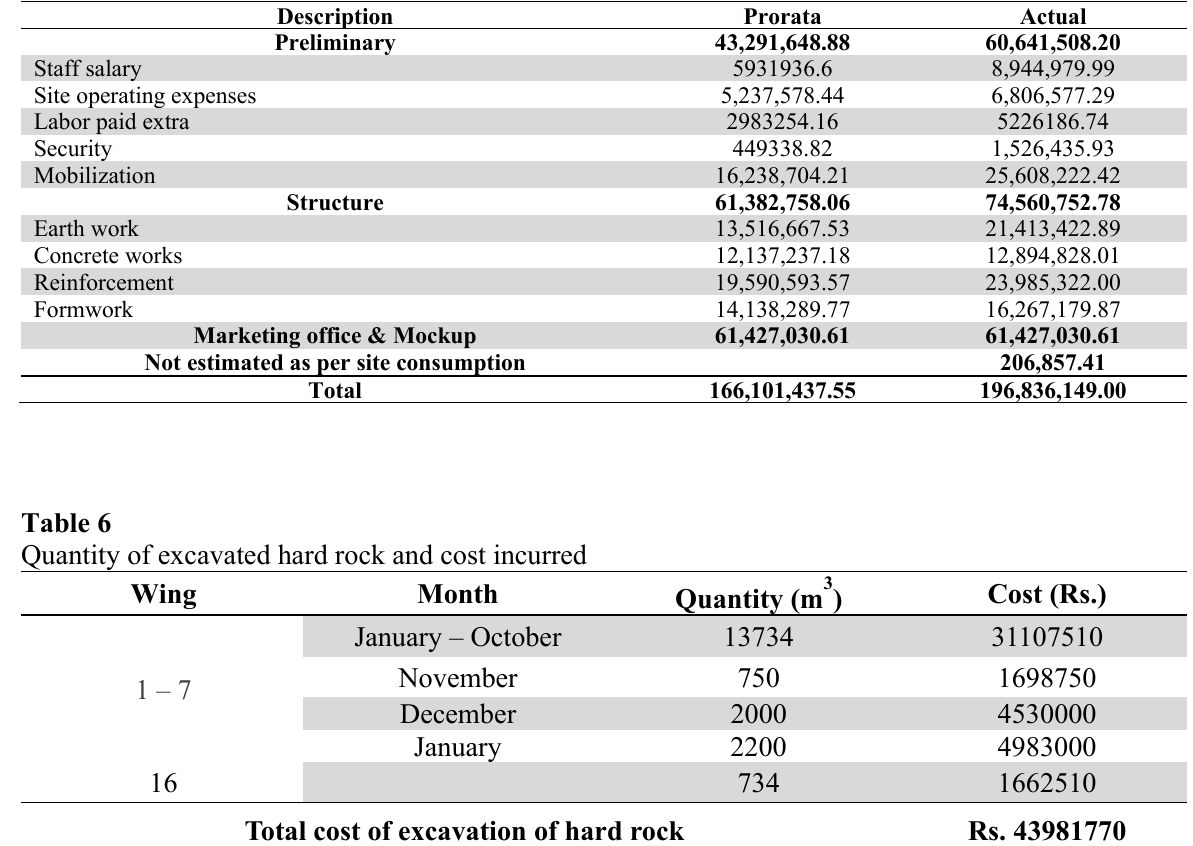
Cost structure of each activity